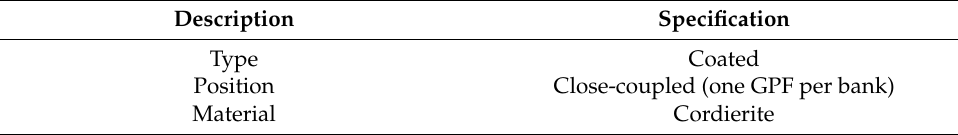
Table 3. GPF specifications.